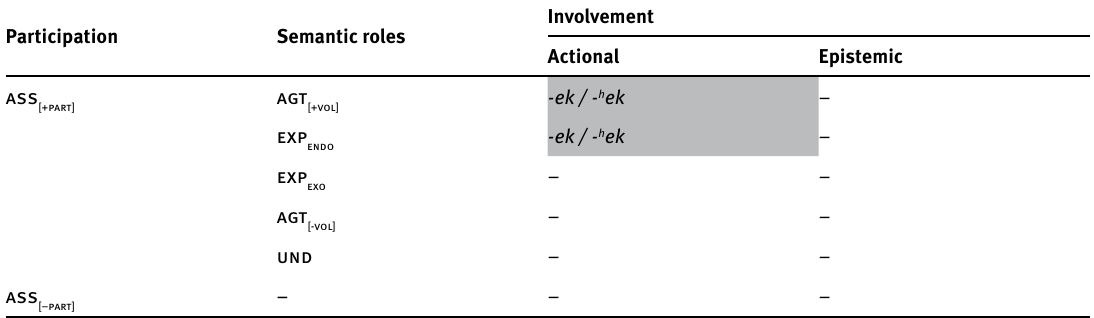
Figure 6 . Modelling Bunan present egophoricity